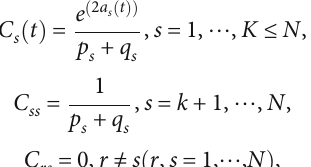
ffiffiffiffiffiffiffiffiffiffiffiffiffiffiffiffiffiffiffiffiffiffiffiffiffiffiffi _ a + q ð Þ p ð 1 t 1 1